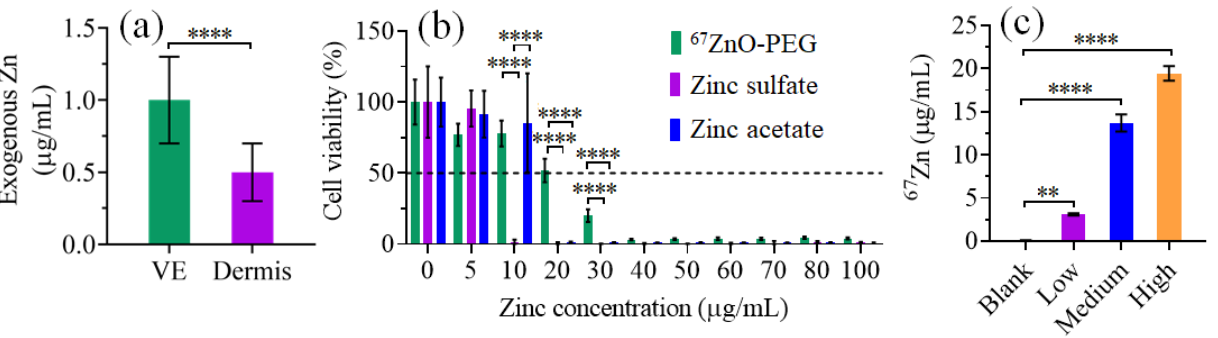
Figure 6. ( a ) Exogenous C 67 Zn expressed in µ g/mL, as assayed by LA-ICP-MS in VE and dermis layers (replotted from Figure 5f). ( b ) HaCaT cell viability exposed to zinc acetate, zinc sulphate, and 67 ZnO-PEG NPs for 24 h. The data format: mean ± SD for n = 8 replicates. ( c ) C 67 Zn from supernatant of HaCaT cell-mediated culture media on addition of 67 ZnO- PEG NPs measured by ICP-MS. Blank, Low, Medium and High stand for cell incubation with 0, 5, 25 and 50 µ g/mL of 67 ZnO-PEG NPs, respectively. The data format: mean ± SD, n = 3. (**) and (****) show significance difference levels at p < 0.01 and p < 0.0001, respectively.